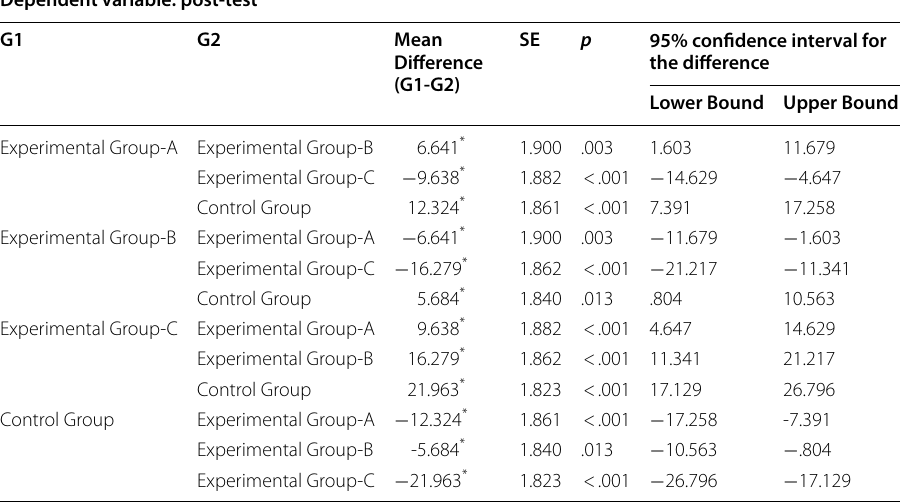
Table 6 Bonferroni posthoc test